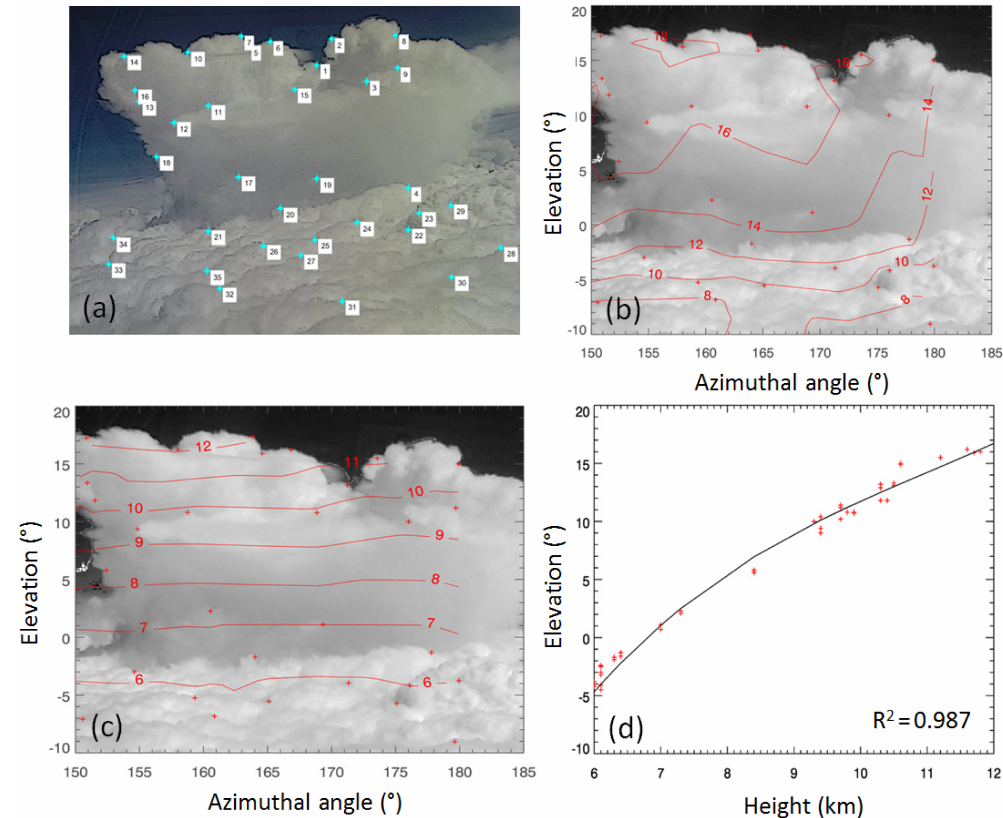
Figure 6. (a) Cloud image from GoPro camera with enhanced edges and selected tie points from 19 September 2014. (b) Calculated distances inkm to the individual cloud points for the cloud scene displayed as isolines. (c) Corresponding isolines of calculated heights. (d) Relationship of height and elevation angle derived for the cloud case including a polynomial fit with a correlation coefficient of R 2 =